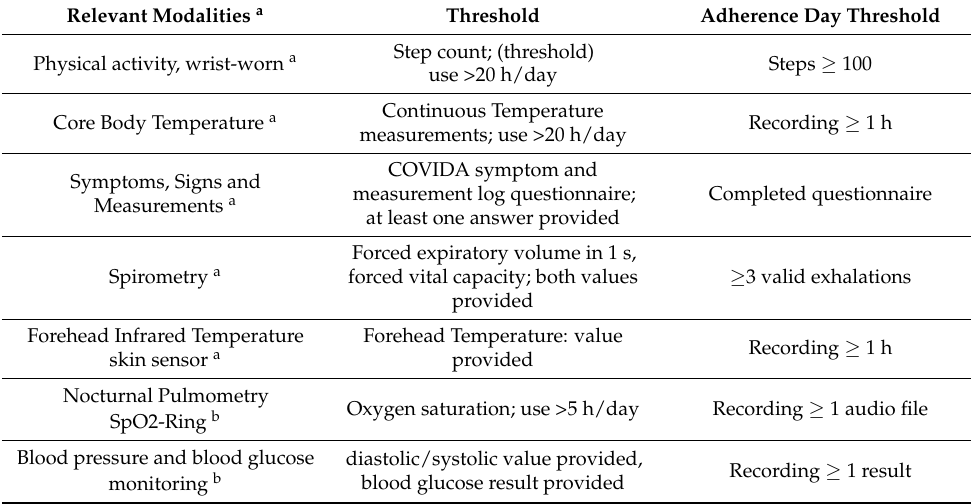
Table 1. Overview of the sensor and adherence